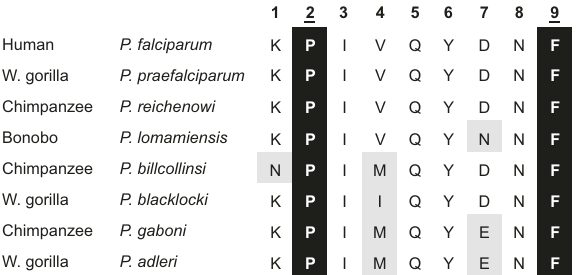
Fig.4|LimitedvariationintheLSA-1ls6epitopeof Laverania . Shownareamino acid sequences of the nonamer ls6 peptide for LSA-1 proteins of eight Laverania species. Sequences are listed, along with their natural host, according to their phylogenetic relatedness 13,14 . Positions 2 and 9 (underlined) are the conserved anchor positions (highlighted black) that hold the peptide within the MHC-B peptide-binding groove. Grey highlights residues that differ from that of P. falciparum